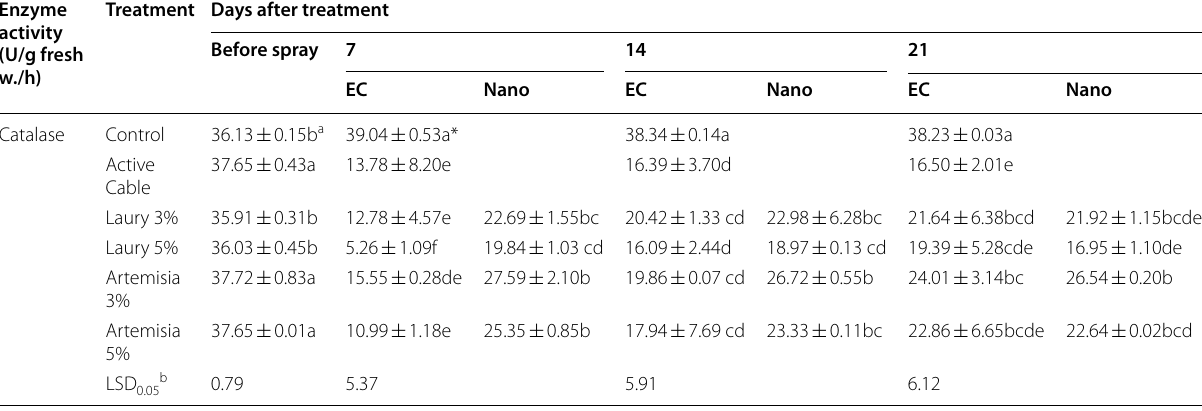
Each value represents the mean of three replicates a Means with different letters within each interval were significantly different at the 0.05 level (Duncan’s multiple range test) b Least significant difference at 0.05 level of probability